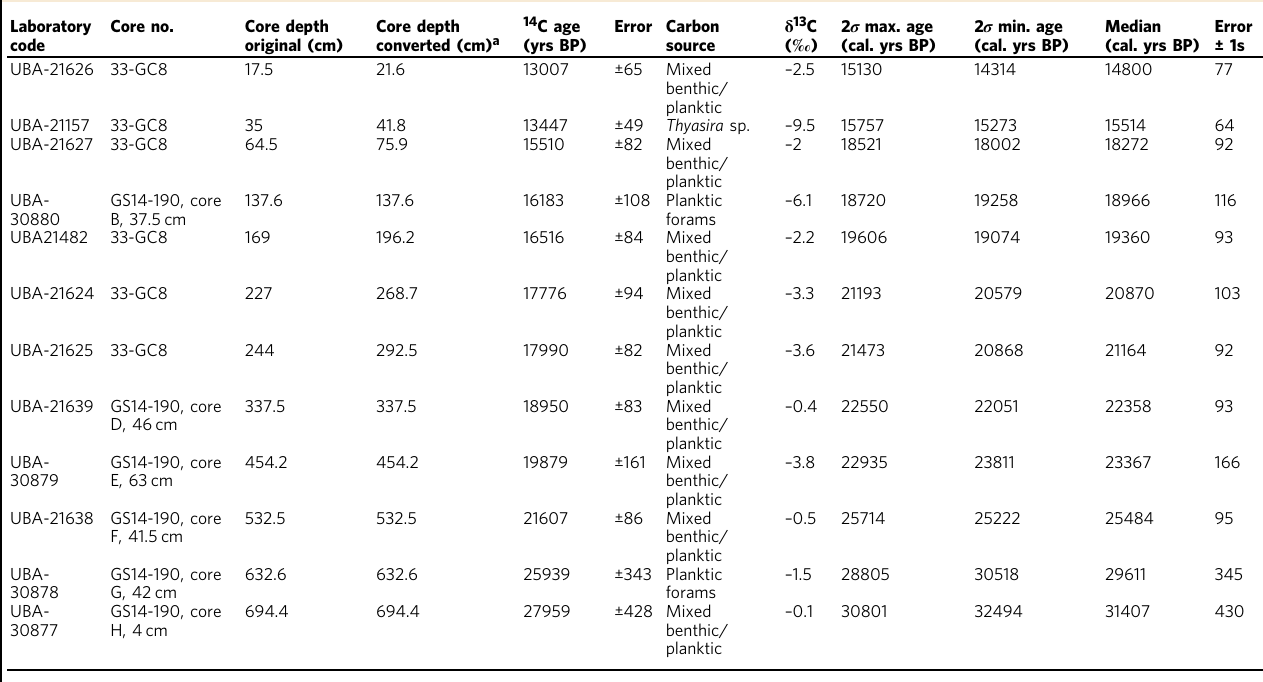
a Indicates converted core depth for GC08 outlined in Table